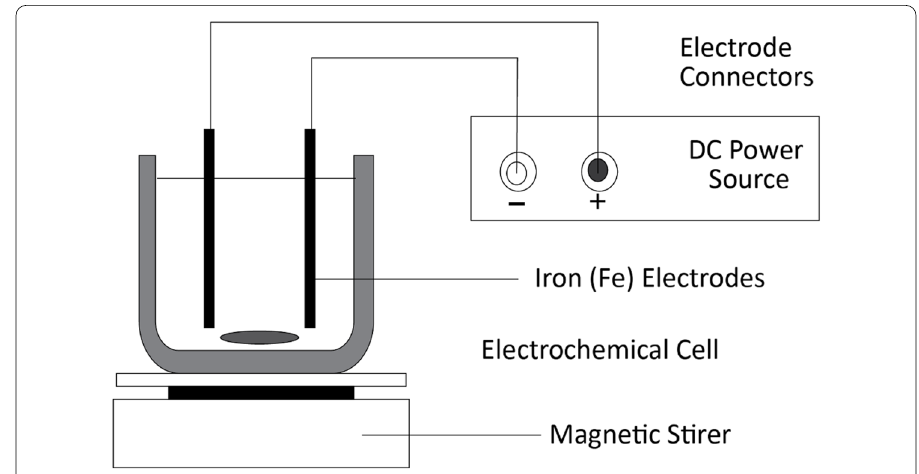
Fig. 1 Schematic diagram of the Electro-Fenton